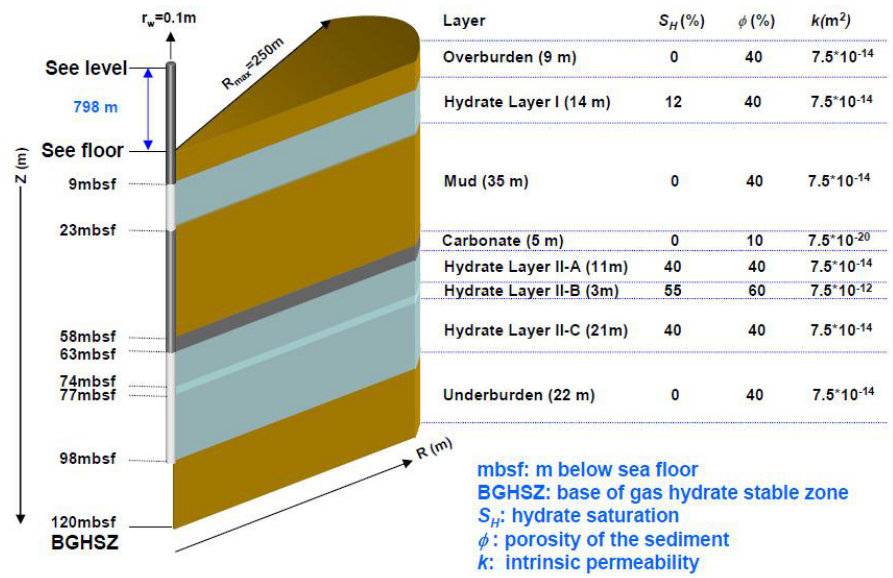
Figure 4. Description of the cylindrical system used in the simulations.